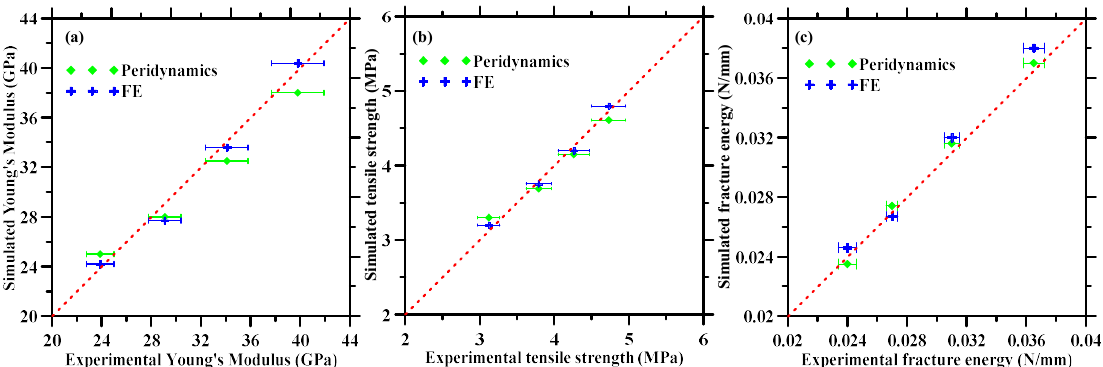
Figure 9. Correlation between experimental and simulated (peridynamics and finite element (FE) approach) ( a ) Young’s modulus and ( b ) tensile strengths and ( c ) fracture energy of mortars with various dosage of waste iron powder.